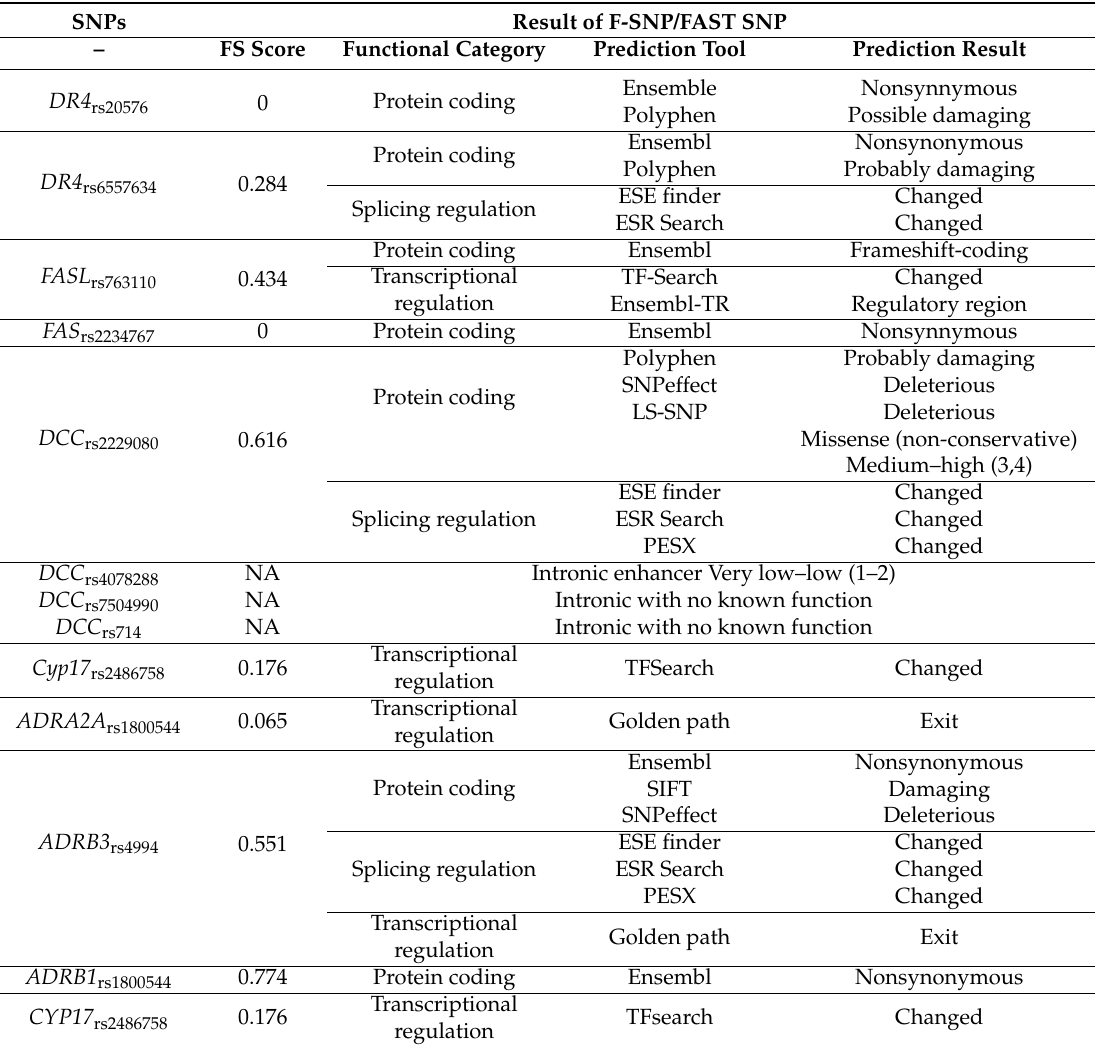
Table 5. Bioinformatic